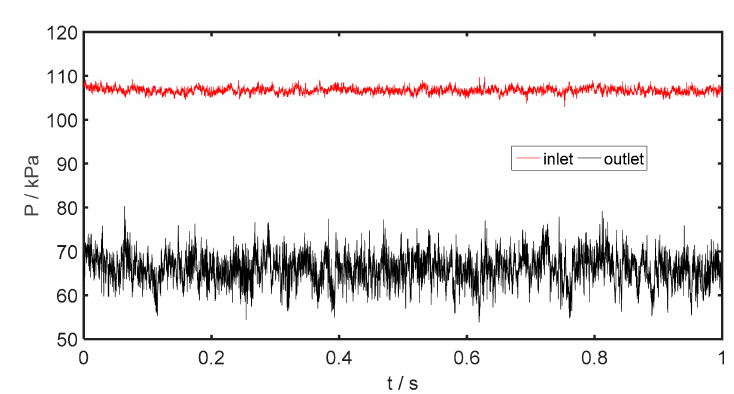
Figure 3. An example of the pressure signals recorded by the inlet and outlet sensors ( σ = 2.08, u in = 10 m /